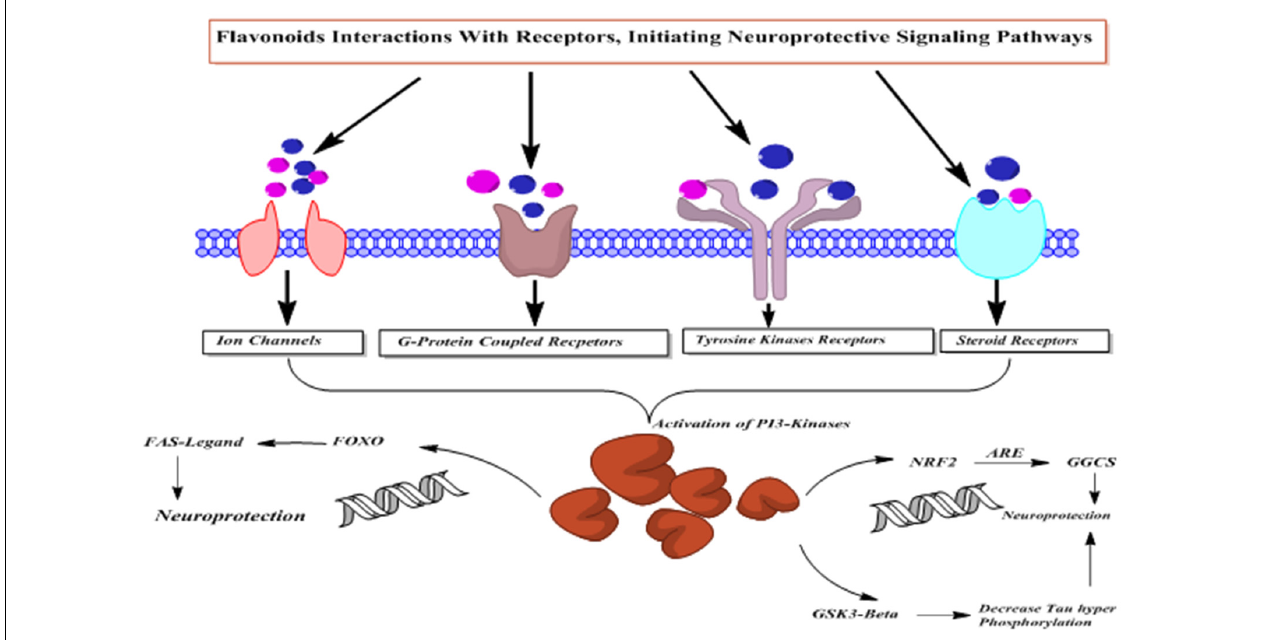
FIGURE 12 | The PI3-kinases activation mediated neuroprotective action of flavonoids.